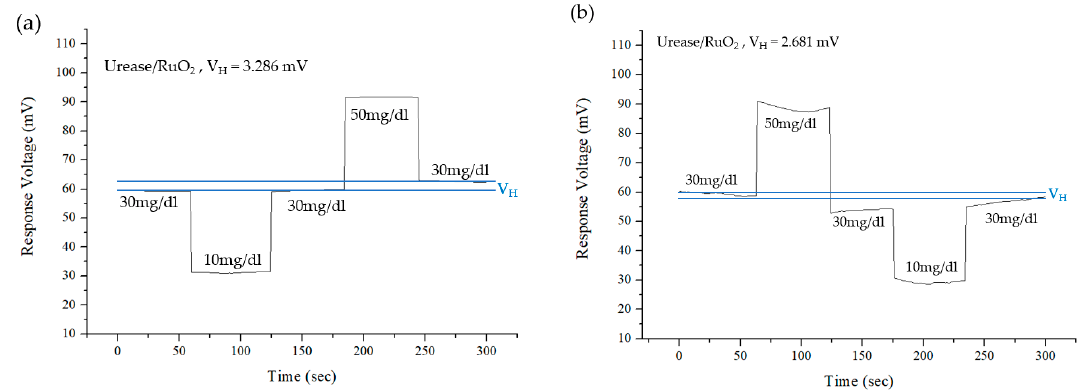
Figure 10. Hysteresis effect of the flexible arrayed RuO 2 urea biosensor . ( a ) 30 mg/dl → 10 mg/dl → .30 mg/dl → 50 mg/dl → 30 mg/dl and ( b ) 30 mg/dl → 50 mg/dl → 30 mg/dl → 10 mg/dl → 30 mg/dl.